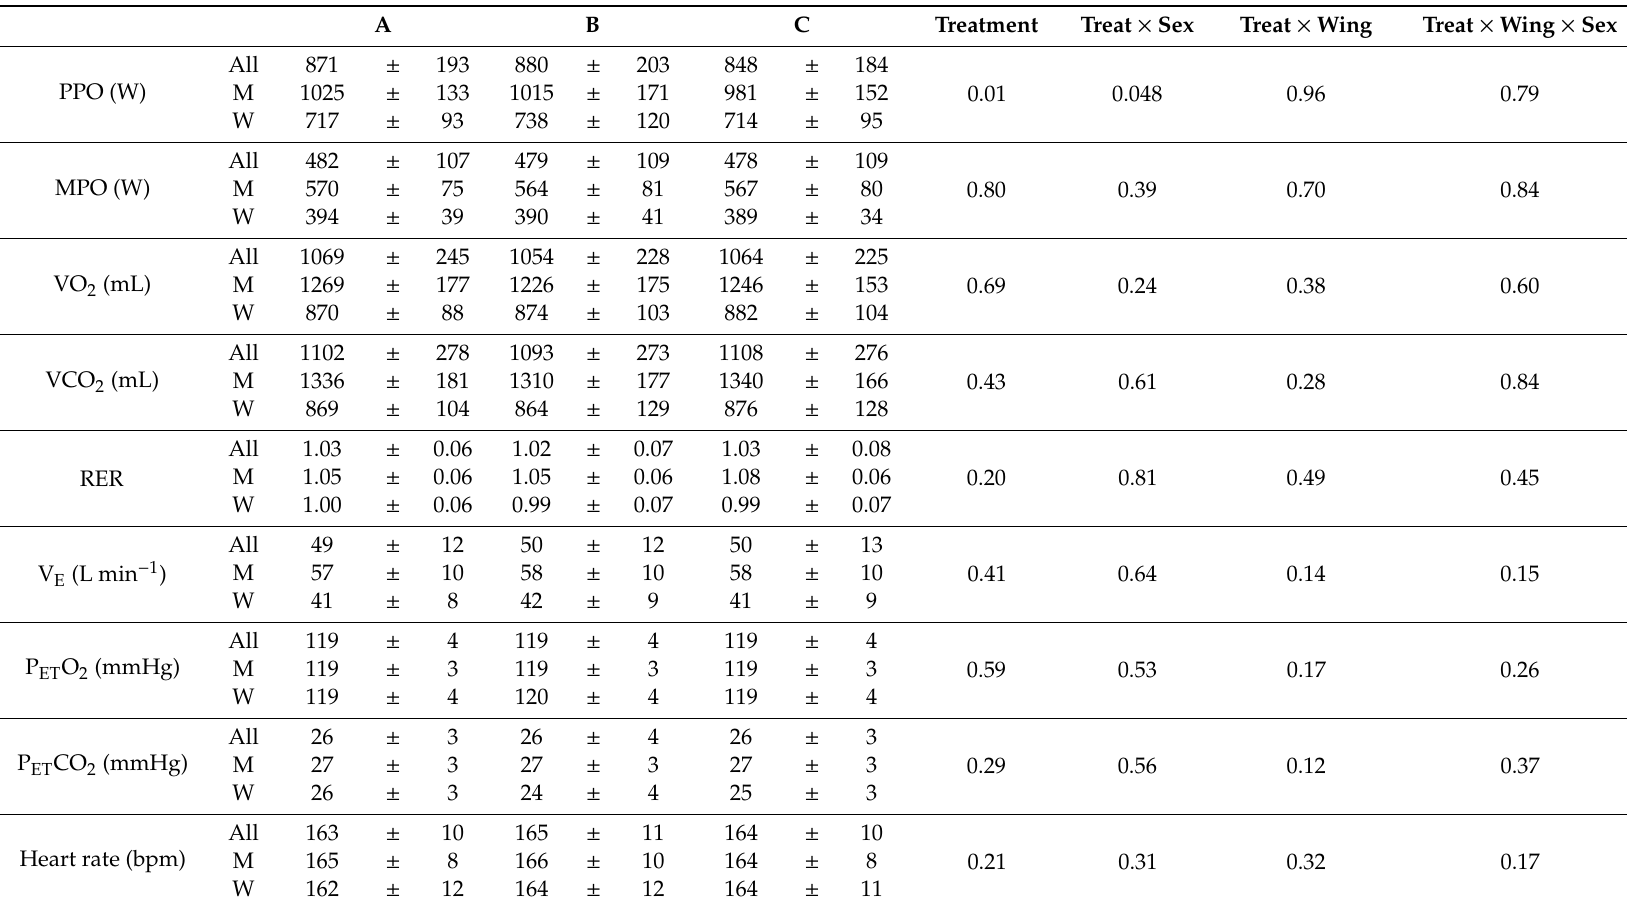
Table 2. Power output and cardiorespiratory variables during the first three 30 s Wingate tests (mean ±